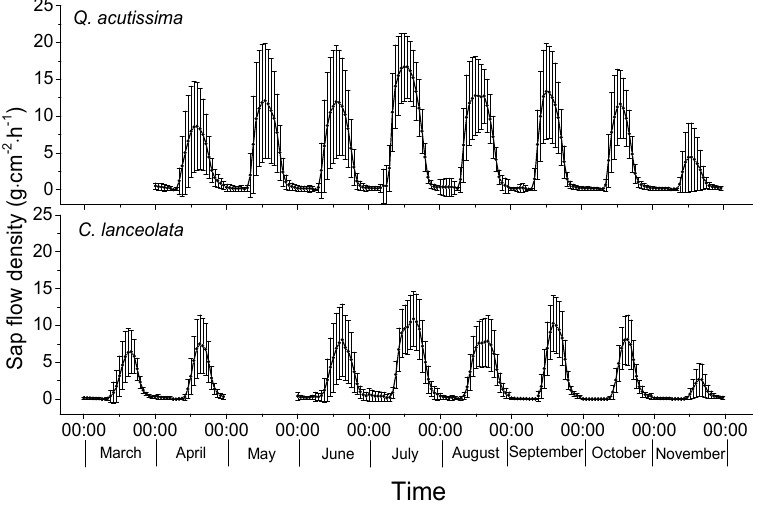
Figure 5. Daily variations of averaged sap flow density in different months.